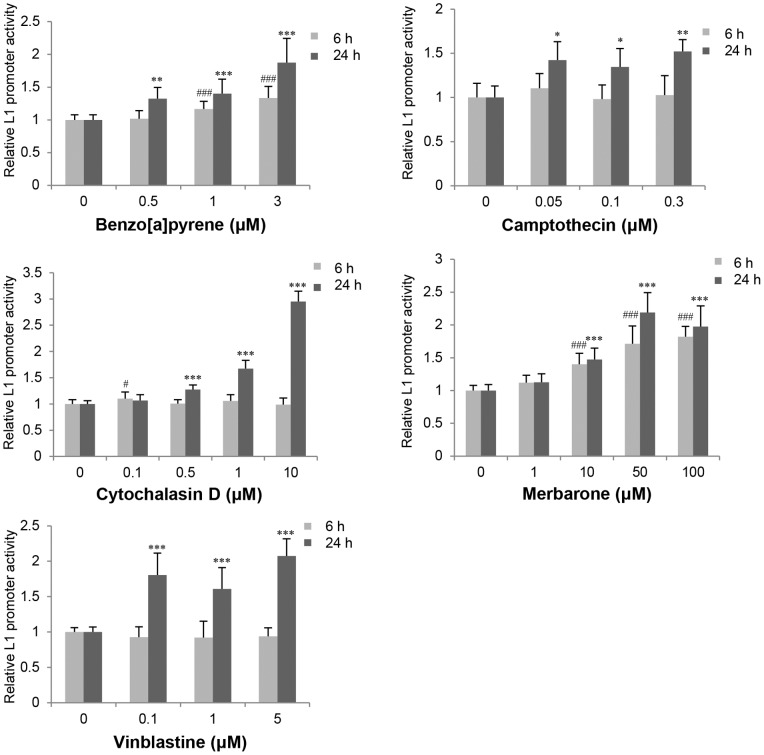
Effects of genotoxic agents on L1 promoter activity in HepG2 cells.L1 promoter activity 6 and 24 hours after treatment was evaluated by the luciferase reporter gene assay. Data are the average ratio ± the standard deviation (SD) of the L1 promoter activity in the presence of the test compound relative to that in the presence of the vehicle control from four independent experiments. Each experiment was carried out in duplicate (n = 8), except in the case of 0.5 µM benzo[a]pyrene and camptothecin and 0.1 and 5 µM vinblastine (at least two independent experiments in duplicate, n = 4 or more). Statistically significant differences as compared with the vehicle control for 6-hour and 24-hour treatments are indicated by *and #, respectively (*or #, p<0.05; **p<0.01; ***or ###, p<0.001).